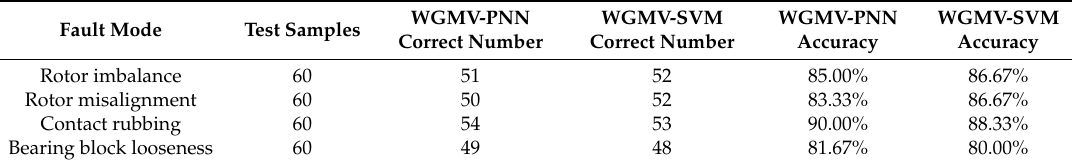
Table 5. Diagnosis results of the WGMV-PNN and WGMV-SVM method using the same